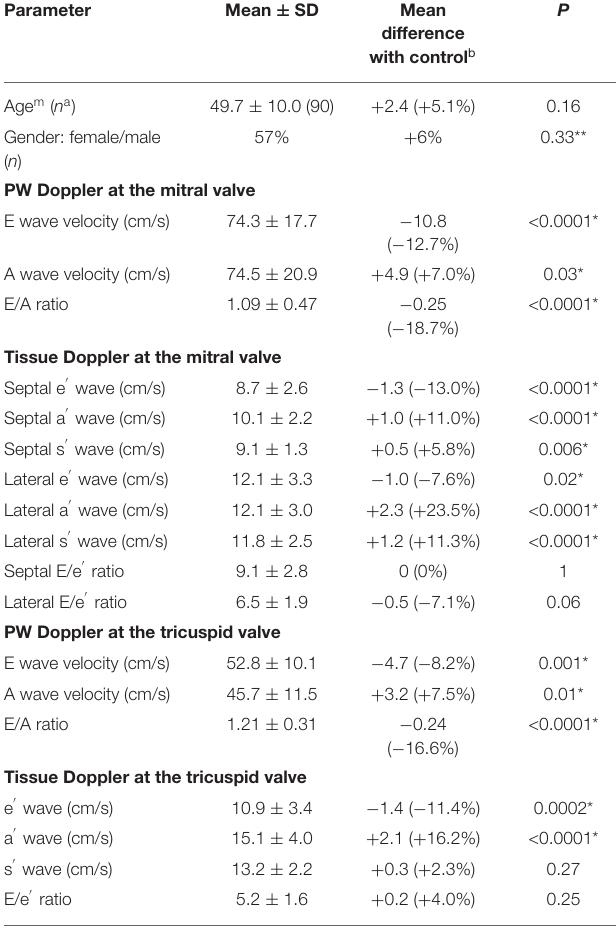
TABLE 3 | Differences in cardiac Doppler parameters between age-matched patients and the normal control.